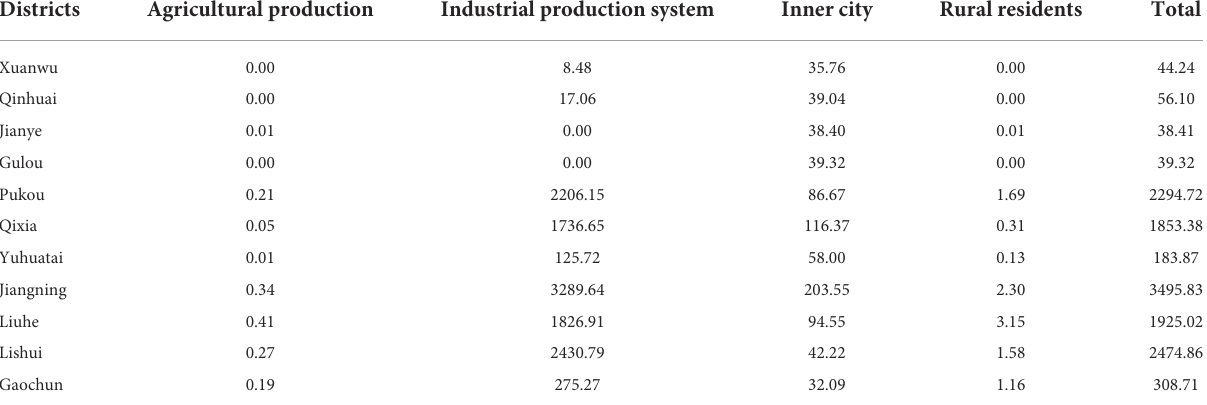
TABLE 2 Carbon emission of each district and land use in Nanjing.